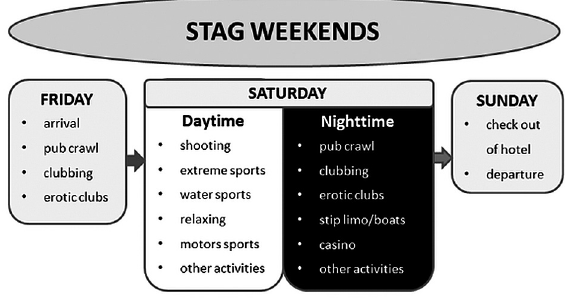
Fig. 8. Typical schedule of a stag weekend based on the analyzed